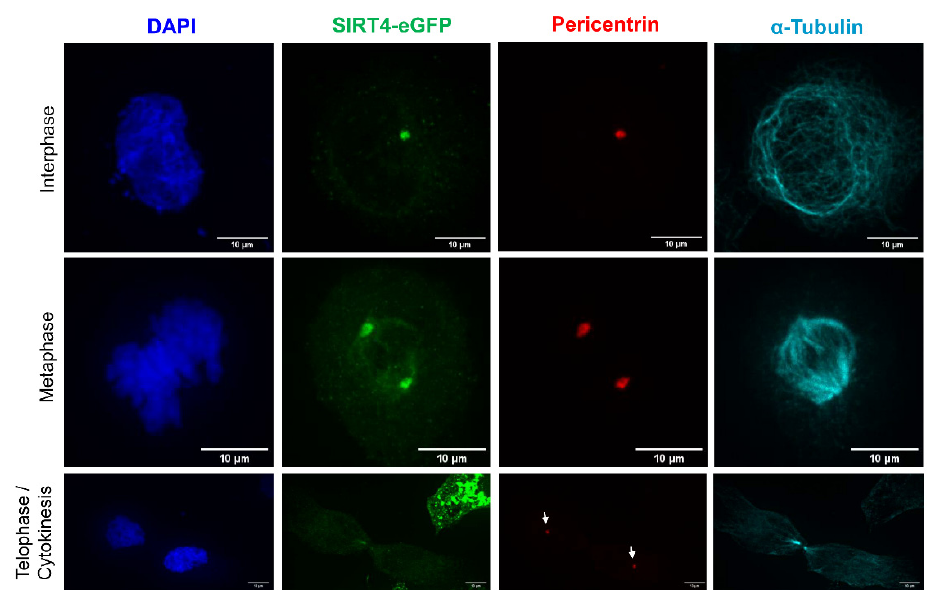
Figure 2. Centrosomal localization of SIRT4-eGFP during interphase and mitotic cell division. An expression construct for SIRT4-eGFP was transiently transfected into HeLa cells and SIRT4-eGFP was imaged by confocal spinning disk microscopy. The corresponding movies of these confocal pictures are provided in the supplementary information (Videos S2–S4). Antibodies against Pericentrin and α -tubulin were employed to visualize centrosomes and microtubules, respectively. DAPI was usedto detect DNA. Bar: 10 µm.